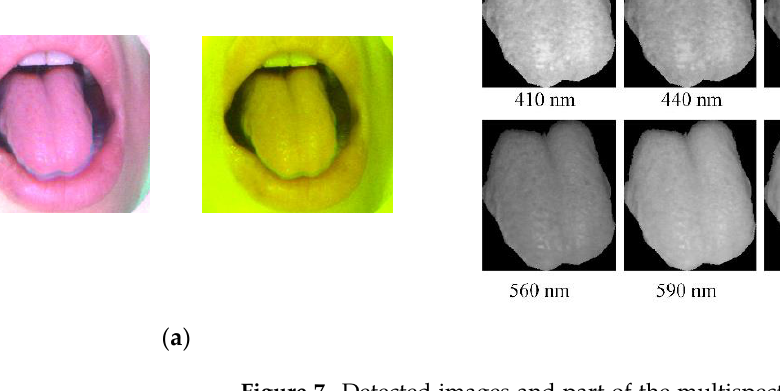
Figure 7. Detected images and part of the multispectral images. ( a ) Two frame images detected. ( b ) Reconstructed multispectral images of tongue region.